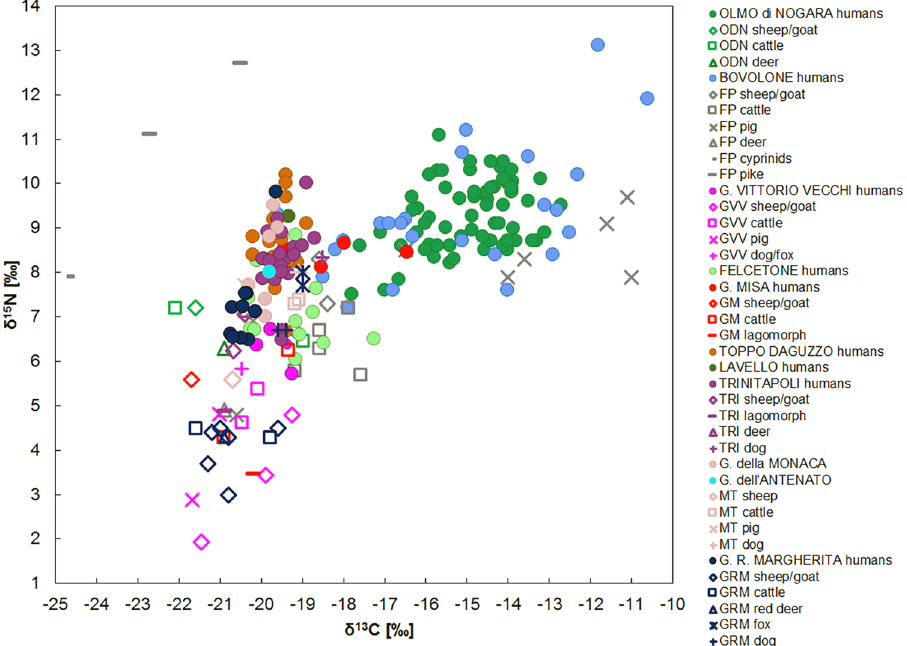
Figure 3. The δ 15 N and δ 13 C human and animal values of the Italian Middle Bronze Age